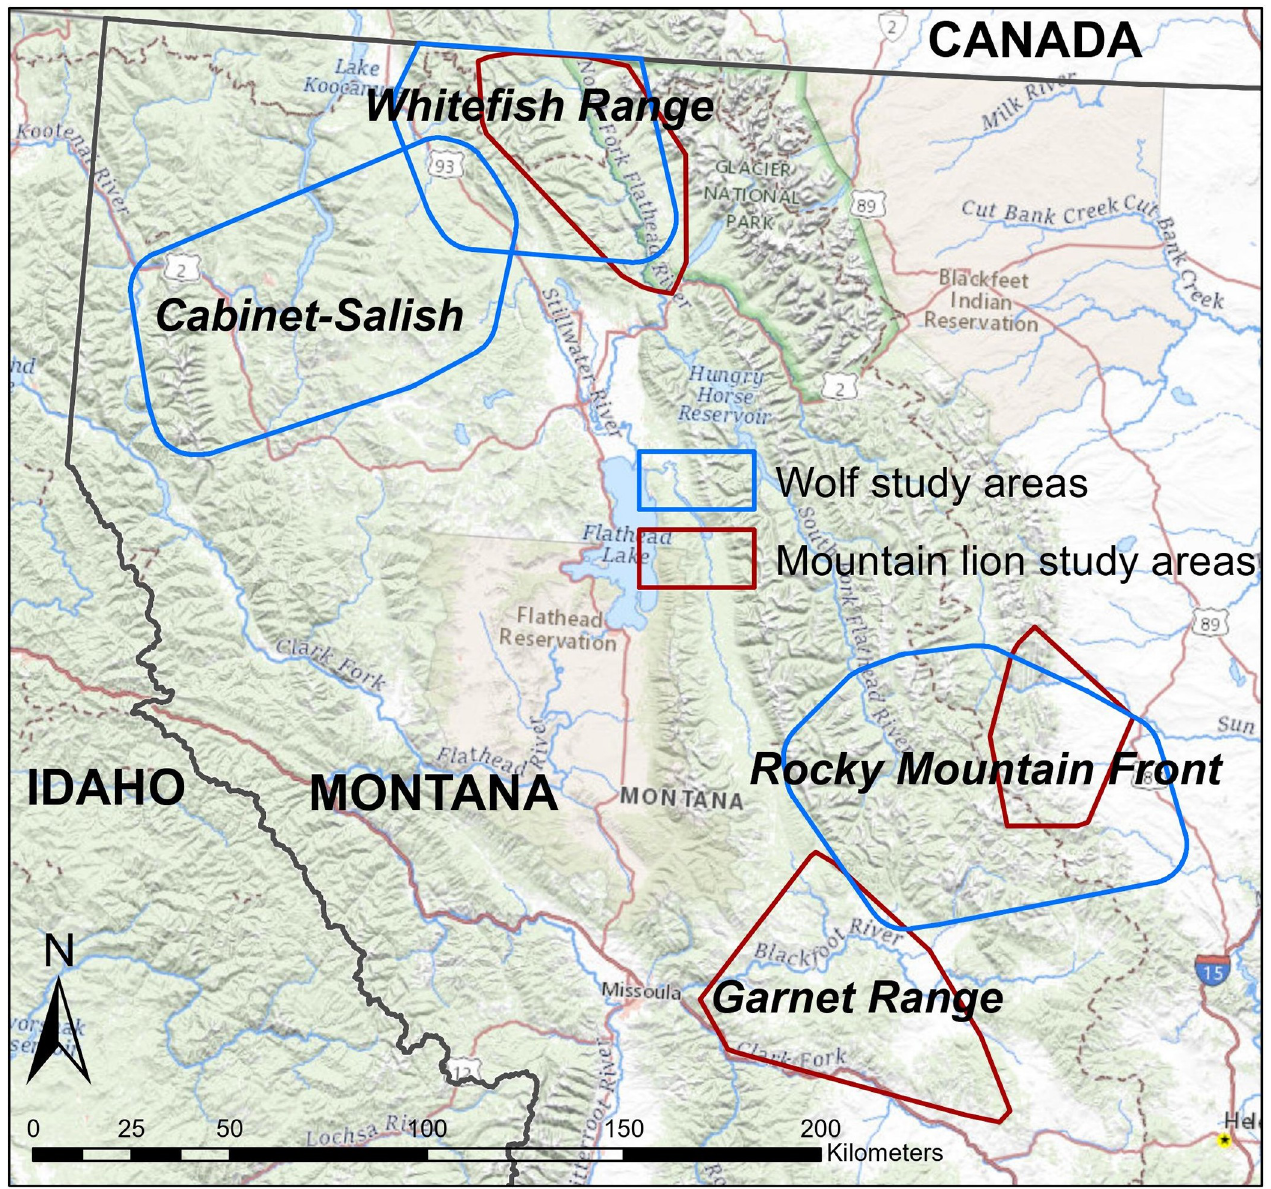
Fig 1. Wolf and mountain lion study areas. Polygons are 100% minimum convex polygons (MCPs) surrounding wolf (in blue) or mountain lion (in red) Global Positioning System- (GPS) or Very High Frequency- (VHF) collar locations during summer that were used for resource selection function (RSF) modelling and testing. Base map was reprinted from the U.S. Geological Survey National Map and is without